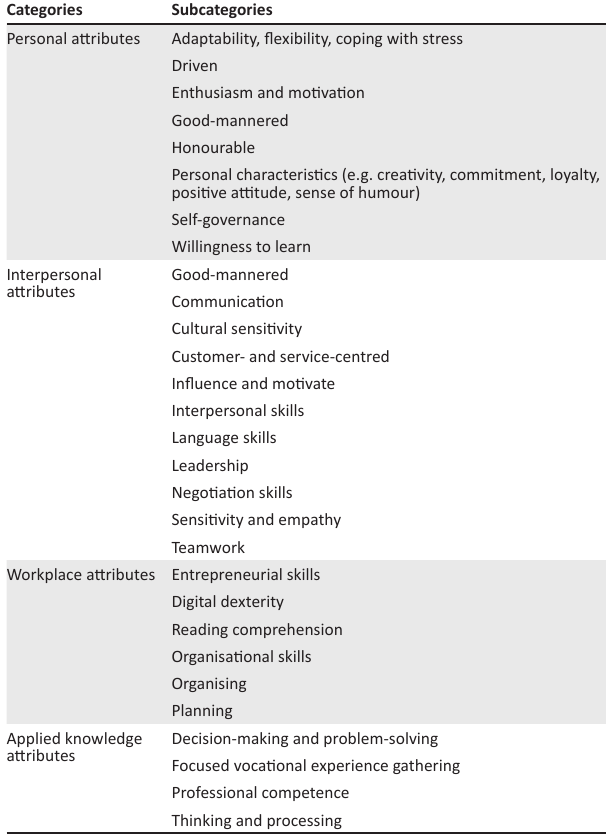
TABLE 1: Employability attributes categories and